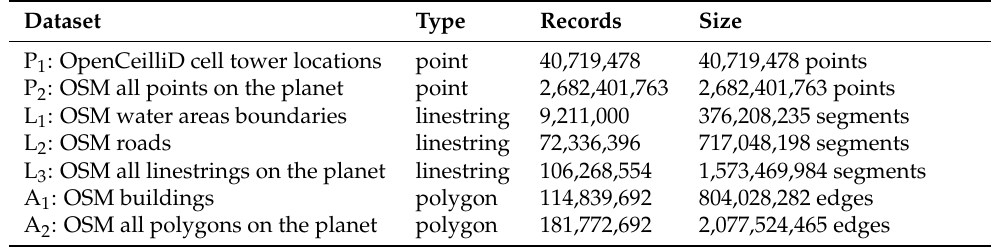
Table 1. Configuration of experimental